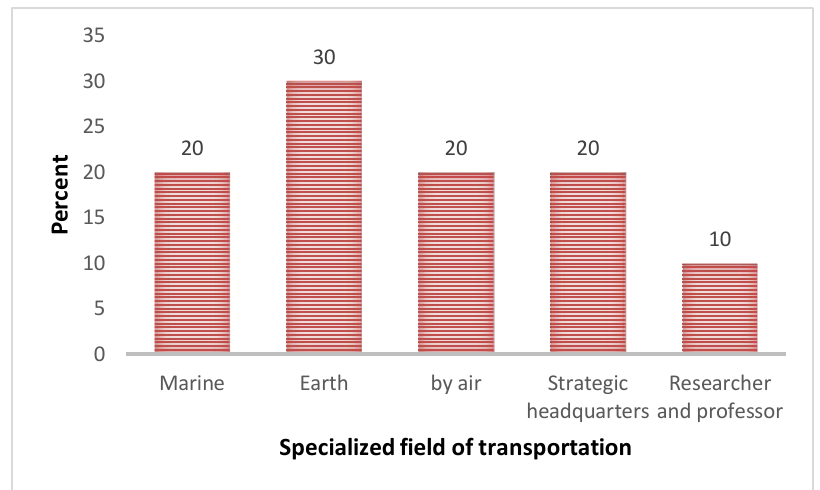
Fig. 5. Specialized field of transportation regarding the respondent